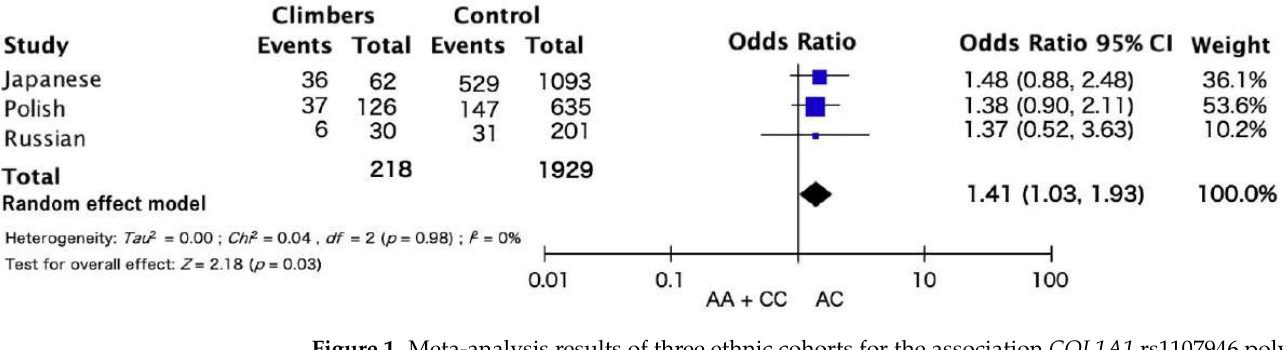
Figure 1. Meta-analysis results of three ethnic cohorts for the association COL1A1 rs1107946 poly- morphism and climbing